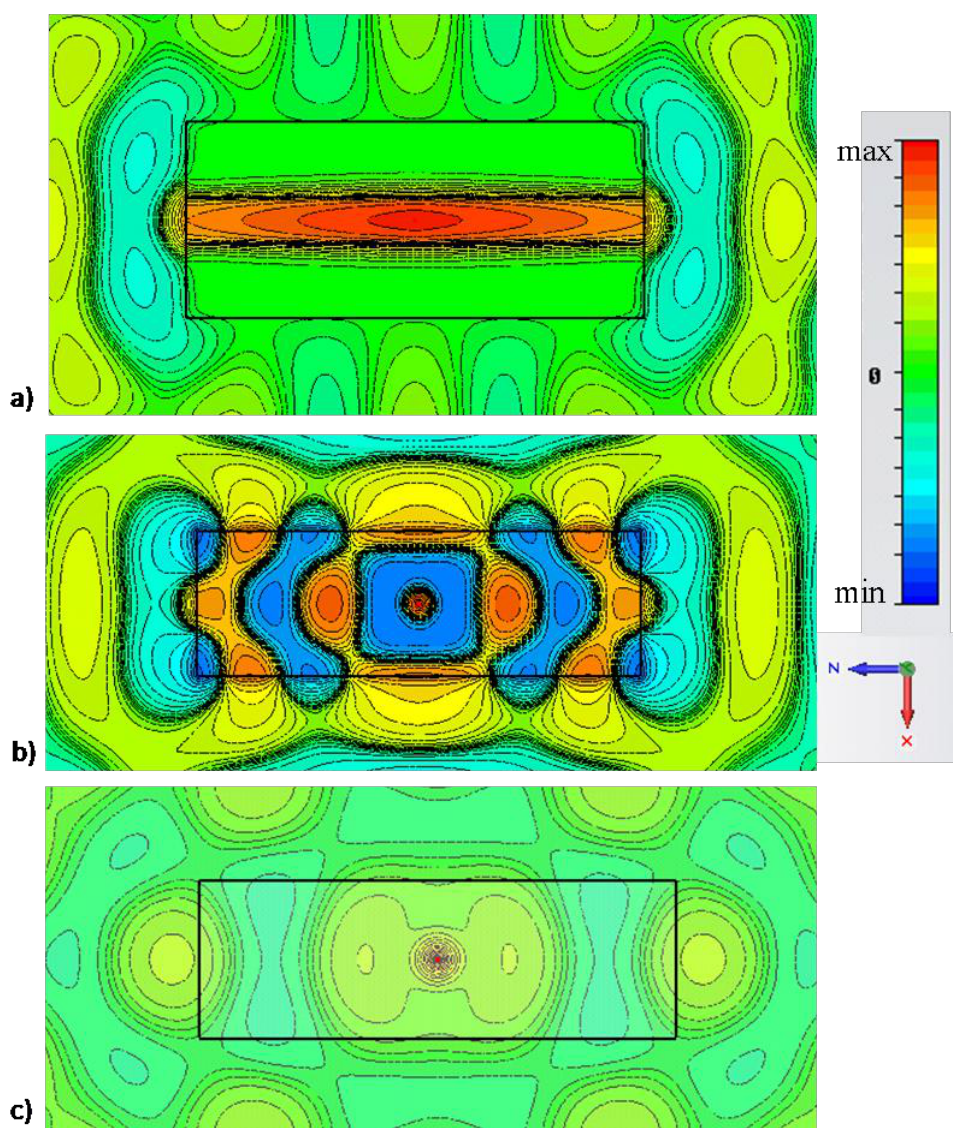
Figure 3. Simulation results for field distribution (snapshot in time) of emitting in the center of the narrow channel of Figure 1 at the cut-off wavelength 750 nm   for: (a) the scenario of Figure 1, (b) the same geometry, but with no side 0 walls; (c) absence of the narrow channel. For this